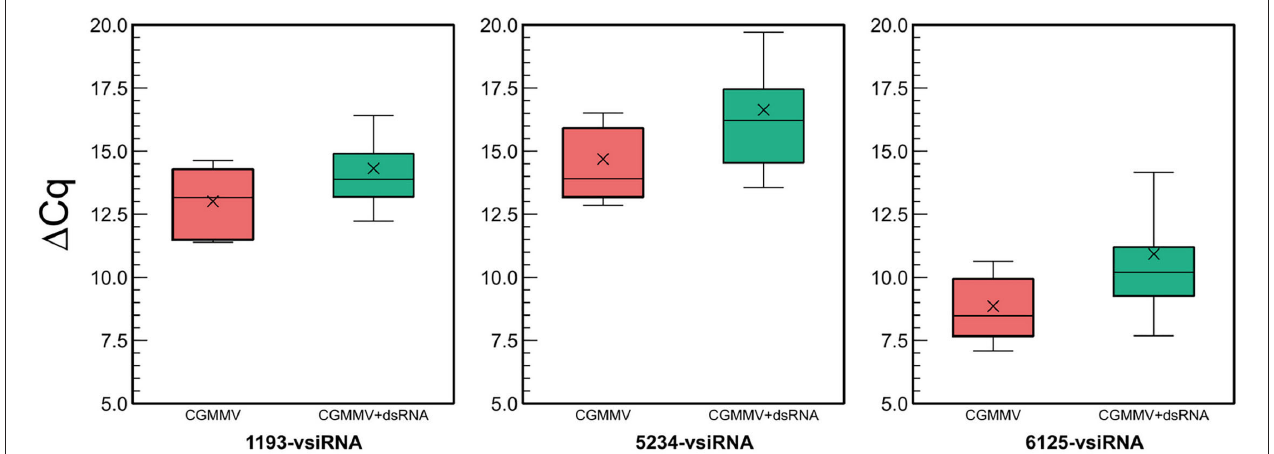
FIGURE 5 | Quantitative differences in vsiRNA titters between untreated (red) and dsRNA-treated (green) CGMMV-infected plants in the experiment carried out in spring. The 1 Cq refers to the differences between the Cq of the different vsiRNAs and the cucumber rRNA control (5.8-rRNA). Lower 1 Cq vsiRNA − 5.8SrRNA values mean higher vsiRNA